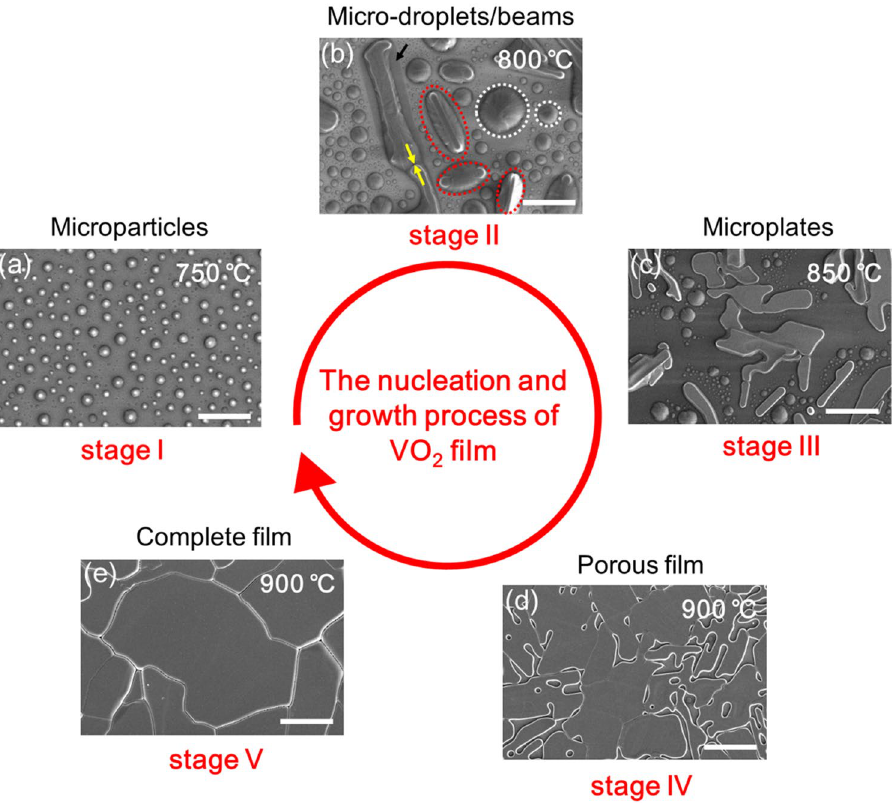
Figure 2. (a–e) Representative SEM images of the growth products from the initial stage I to the final stage V, the scale bars in panels correspond to 20